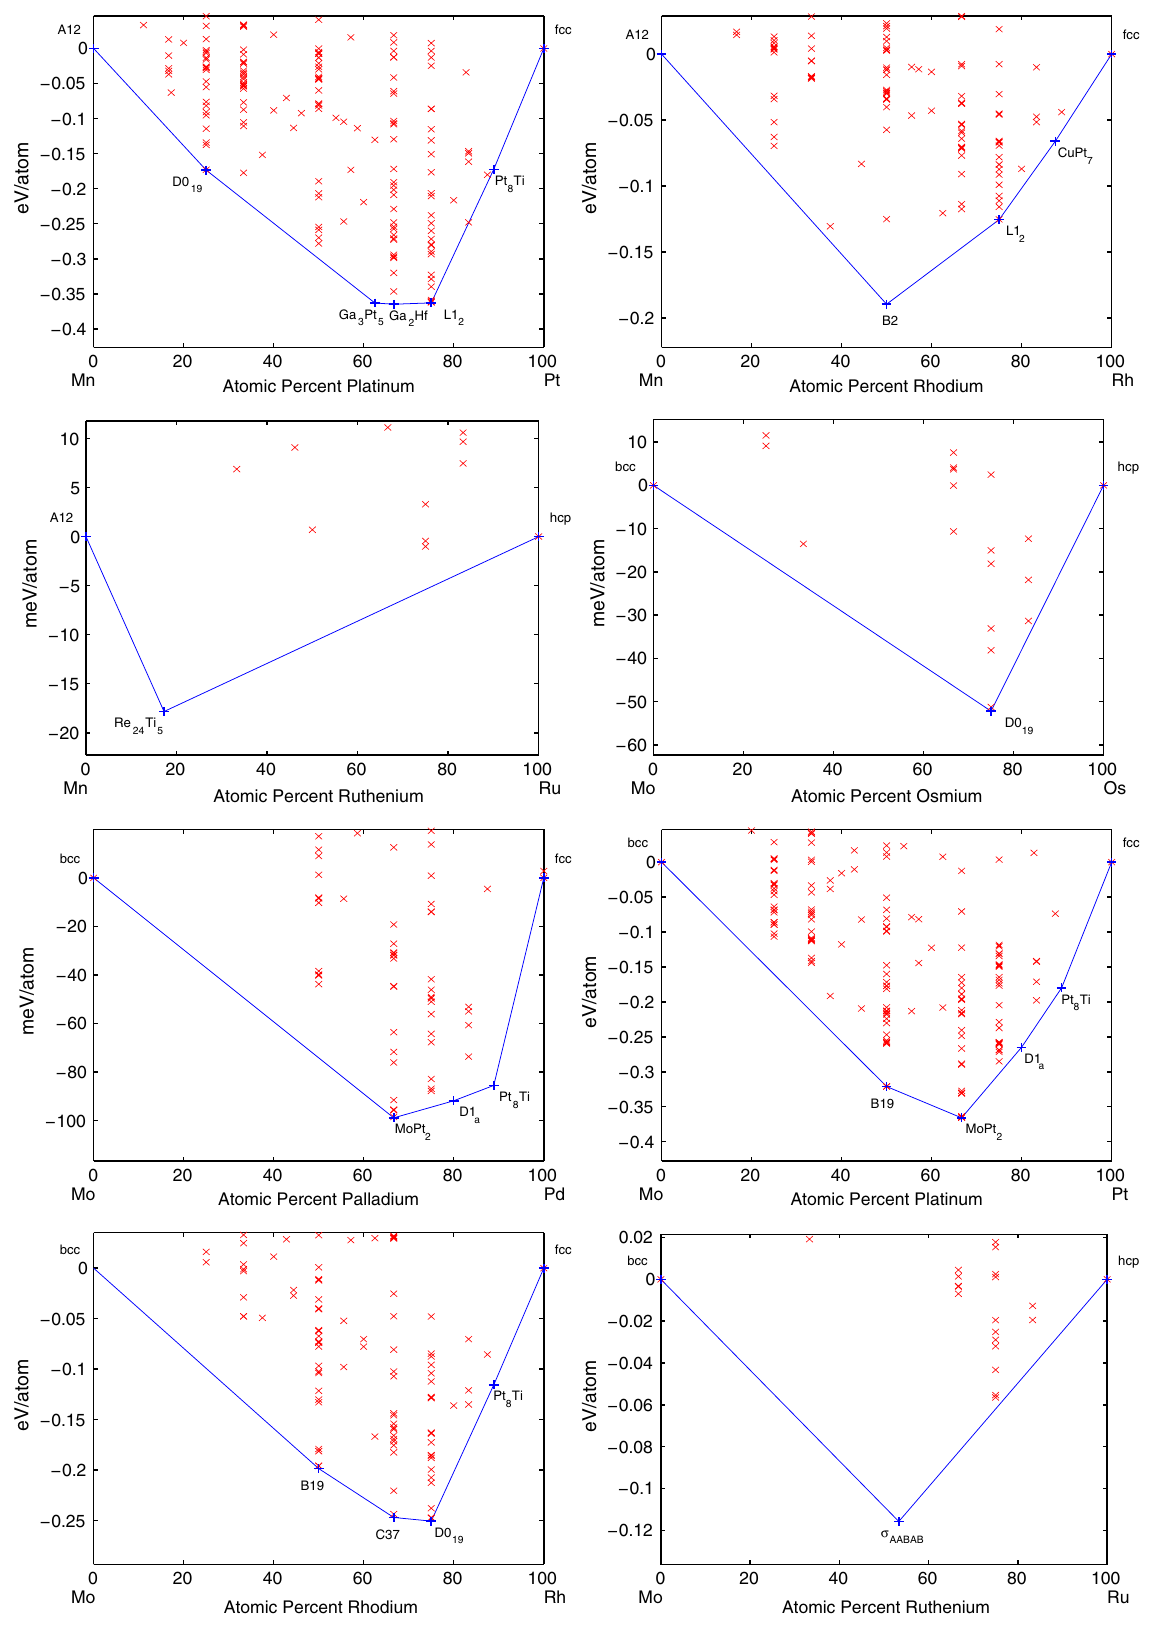
FIG. 11. Convex hulls for the systems Mn-Pt, Mn-Rh, Mn-Ru, Mo-Os, Mo-Pd, Mo-Pt, Mo-Rh, and